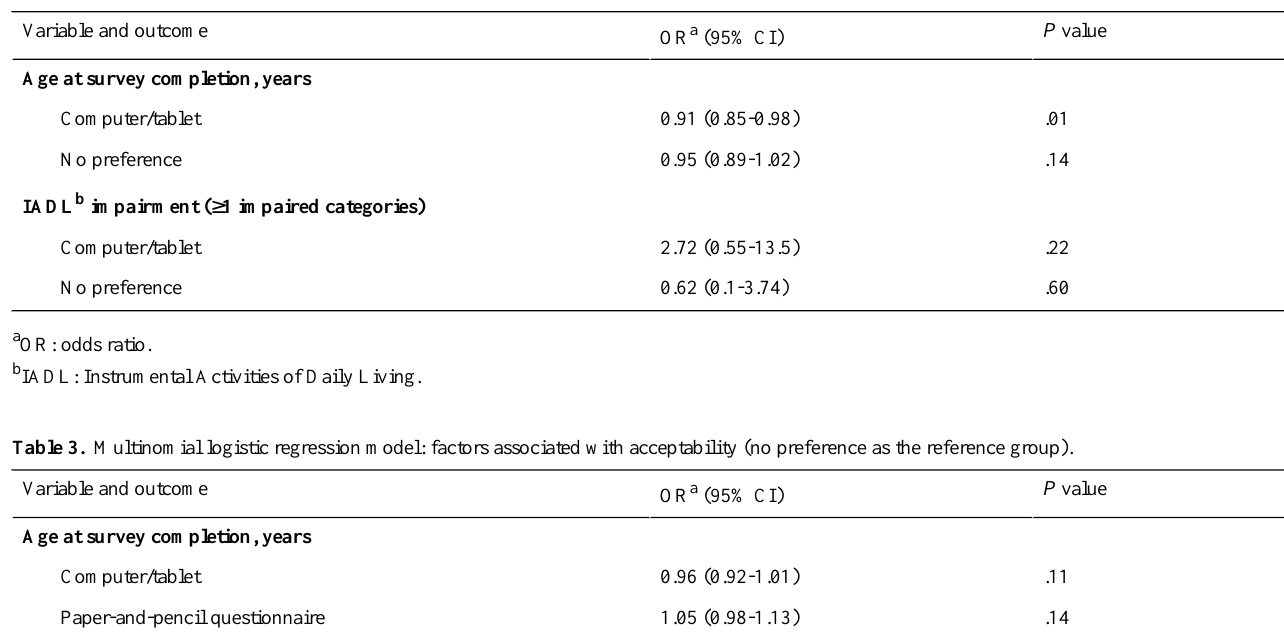
Table 2. Multinomial logistic regression model: factors associated with acceptability (paper and pencil as the reference group). Age at survey completion, years